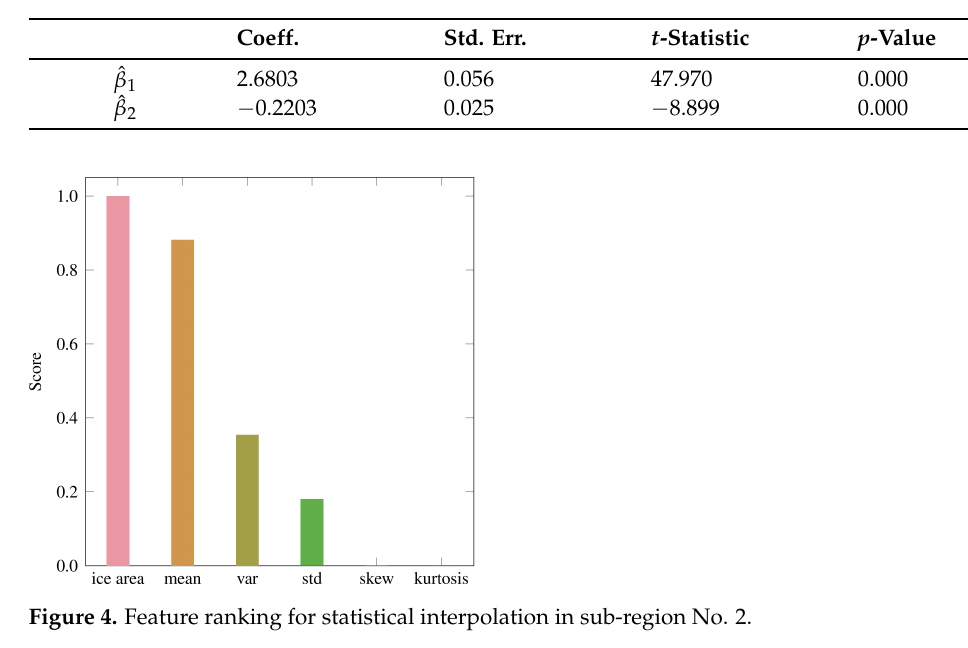
Table 1. Statistical interpolation results.